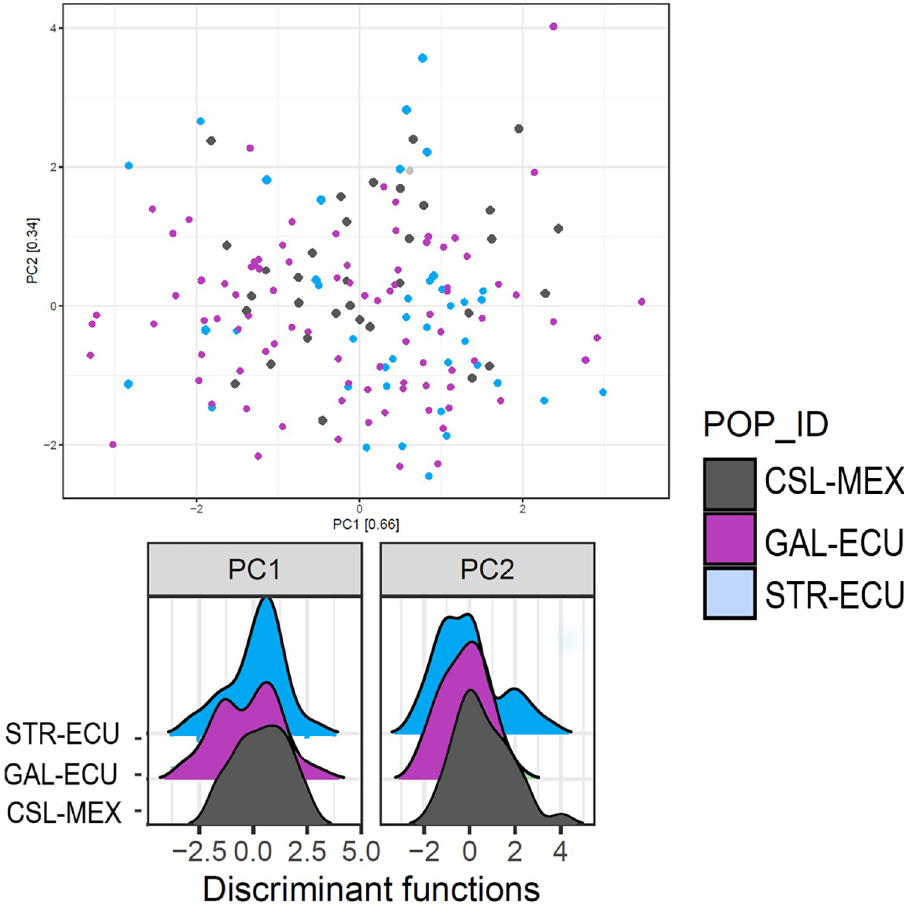
Fig 2. (A) Genetic clusters of yellowfin tuna using analysis of Principal Components (PC) identified by Adegenet (B) Discriminant Analysis of Principal Components of yellowfin tuna within the Eastern Pacific Ocean, using 18,011 markers grouping samples by sampling site. CSL-MEX: Cabo San Lucas, Me´xico (n = 35), GAL-ECU: Gala´pagos Islands (n = 88), Ecuador, STR-ECU: Santa Elena, Ecuador (n = 41).